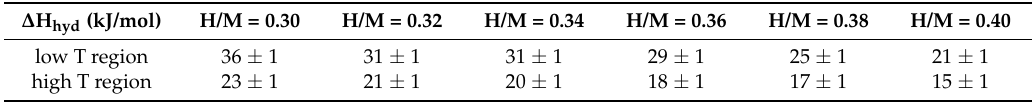
Table 1. The hydrogenation enthalpy, ∆ H hyd ,calculated for various hydrogen concentrations, H/M, values in the low (T ≤ 242 ◦ C) and high temperature (T ≥ 300 ◦ C) region.